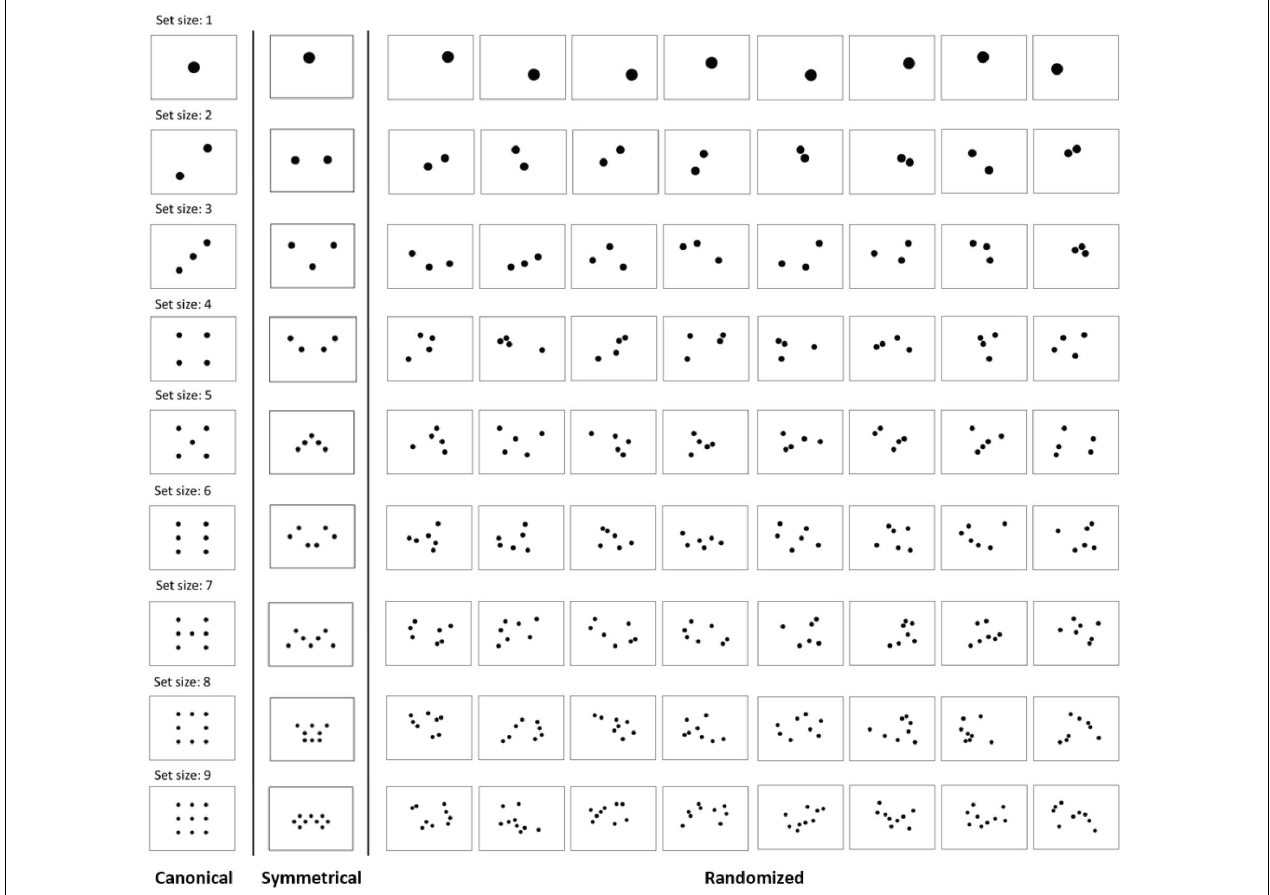
FIGURE 6 | Canonical, symmetrical, and randomized designs in Experiment 2. For symmetrical figures, there were four versions for each set size (only 1 shown above, please see Figure 1 for a complete list of symmetrical